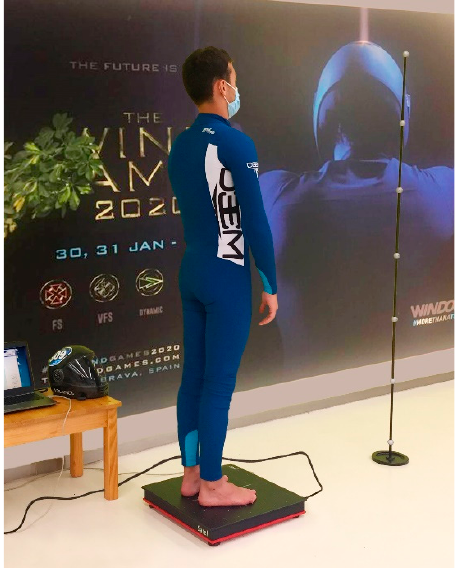
Figure 1. Indoor Skydiver placed in a bipedal position on the